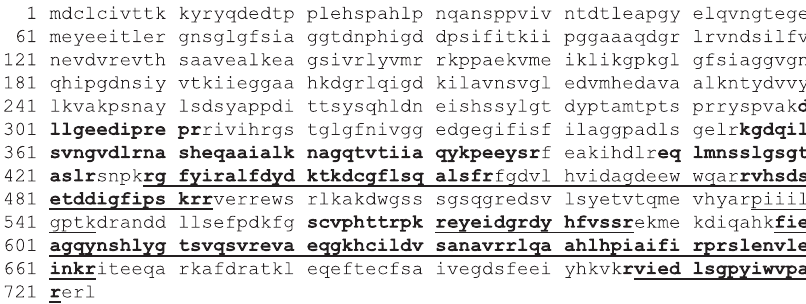
Figure 5. The PDZ 3 –SH3–GK and SH3–GK Domains Are Stable Fragments (A) Coomassie-stained gel (10% acrylamide) of aliquots from limited proteolysis of PSD-95 by Subtilisin proteinase: panels 1 and 3, Precision Plus Protein molecular weight marker (Bio-Rad, http://www.bio-rad.com); panel 2, starting sample prior to proteinase addition; panels 4, Lanes 4–9, Aliquots at 5, 30, 60, 90, 120 min, and 8 h after protease addition (as labeled). Arrows point to stable fragments that were excised from the gel and analyzed by mass spectrometry as described in Methods. (B) Sequence of Rat PSD-95: underlined are the peptide sequences identified by mass spectrometry from the ; 34 kDa stable fragment corresponding to residues 429–721 (33,944 kDa). In bold are the sequences derived from the ; 48 kDa stable fragment comprising residues 300–721 (47,796